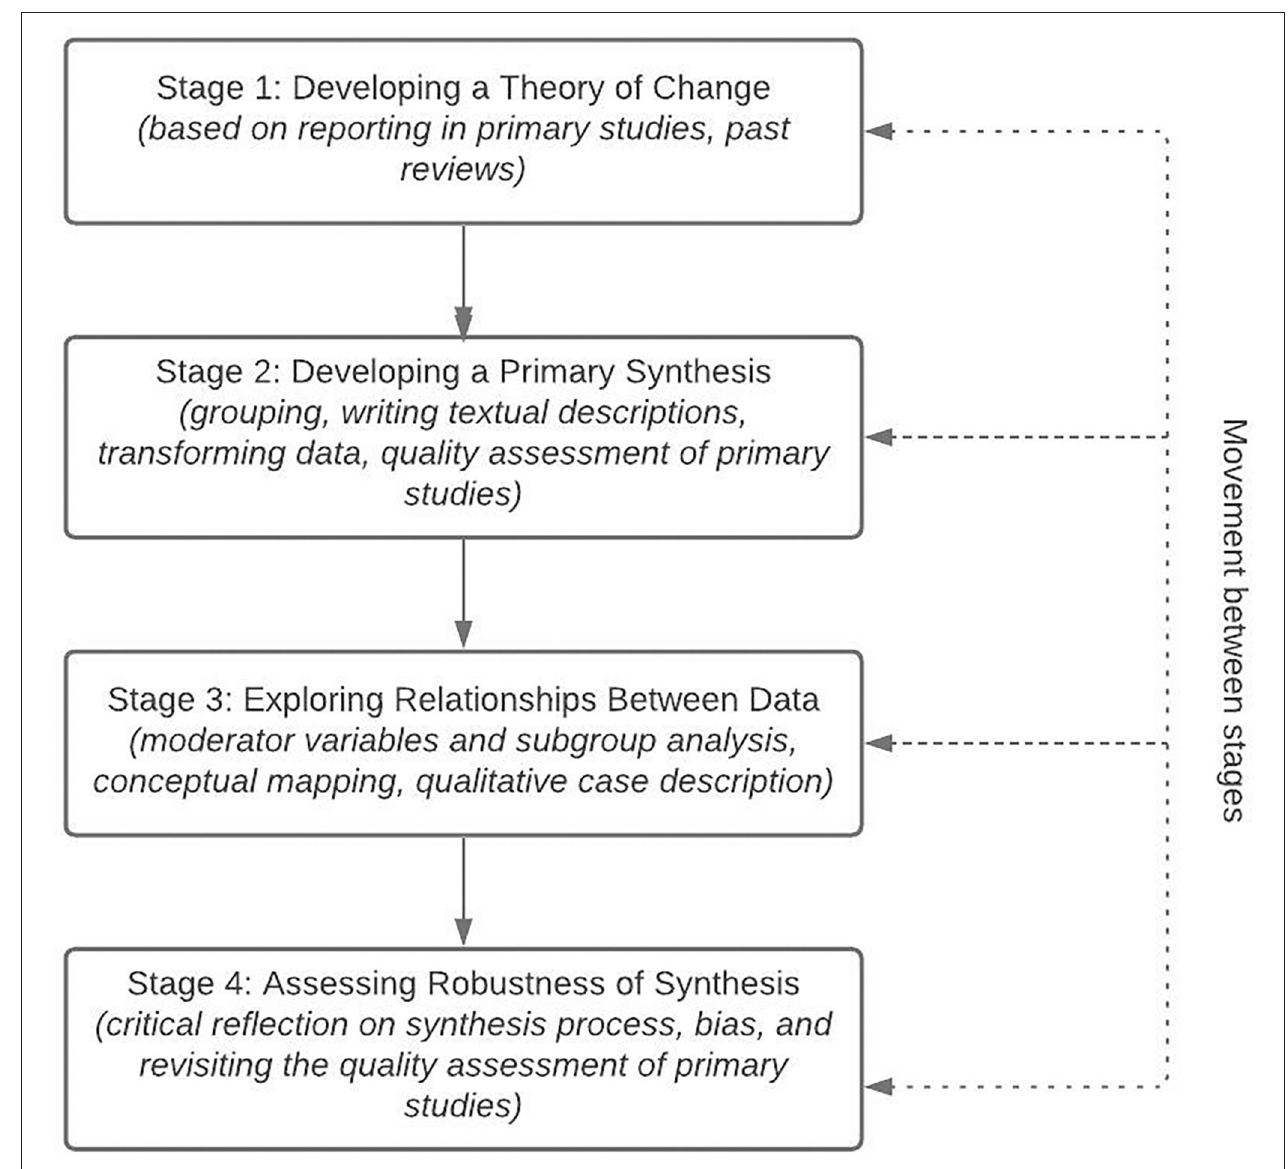
FIGURE 2 | Process of narrative synthesis of quantitative data, adapted from Popay et al. (2006).